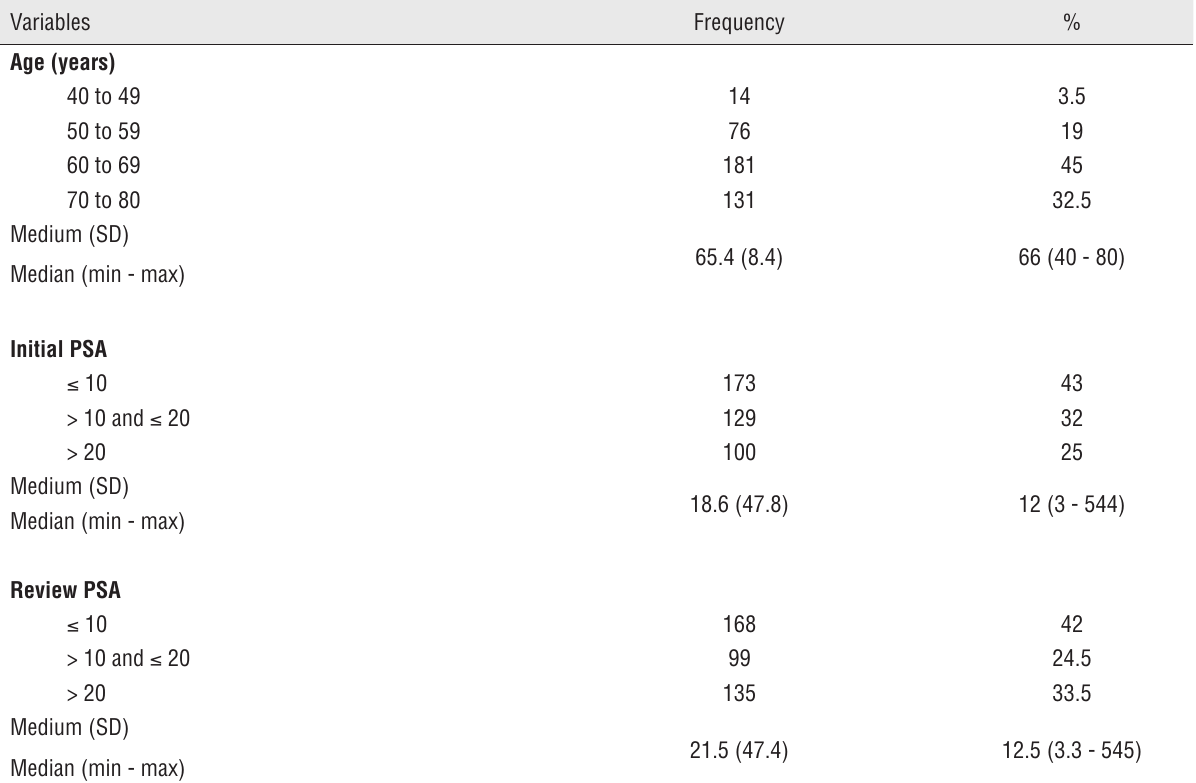
Table 1 - Patients